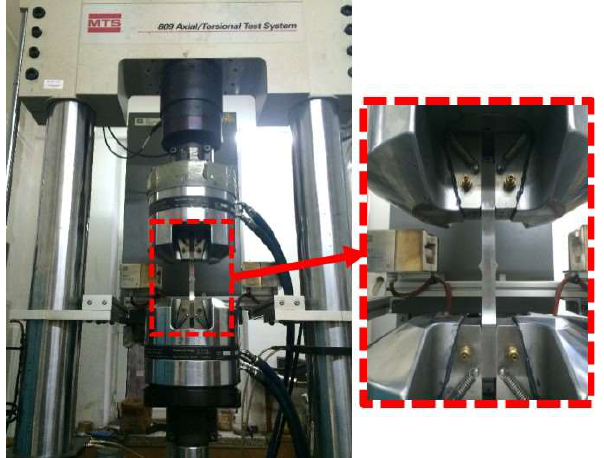
Figure 12. Fatigue testing system (MTS 809).